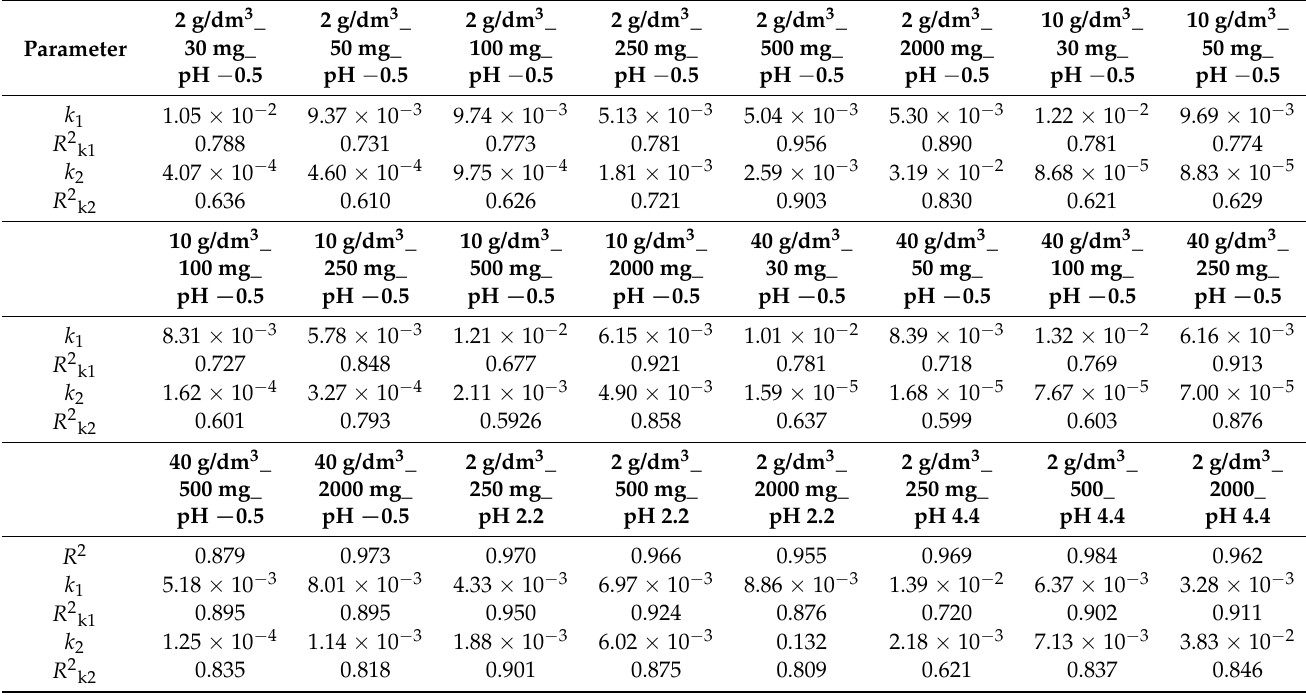
Table 4. The PFO and PSO kinetic parameters for Dowex G26 (abbreviation: initial concentration of Cr(III)_mass of sorbent_pH).